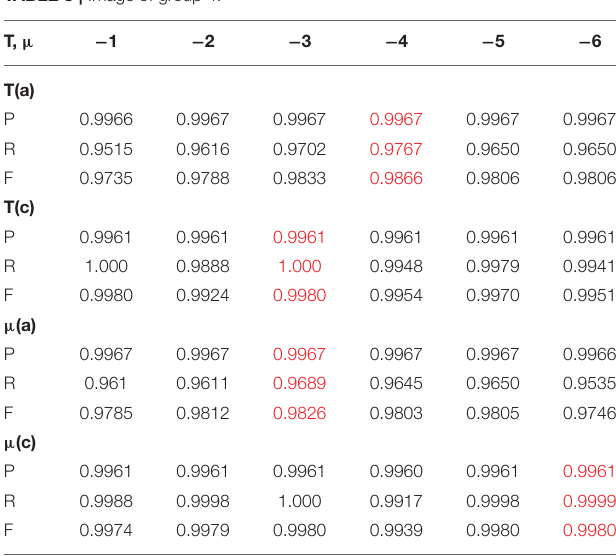
The range of T and µ was from − 1 to − 6. The red color indicates the best value and blue color indicates next best value for different parameters that do not change.